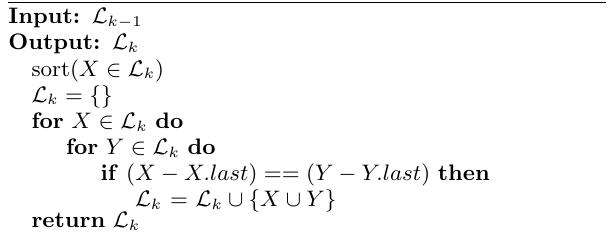
Algorithm 3 Apriori generation